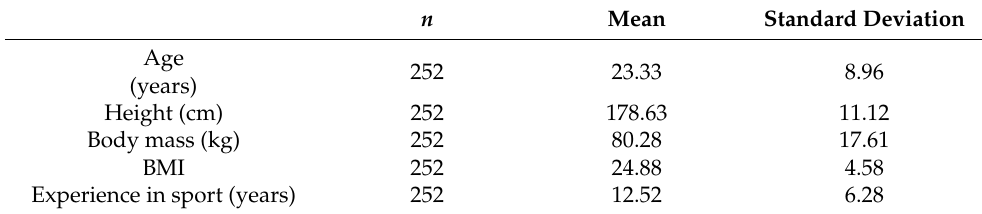
Table 1. Characteristics of the participants in the